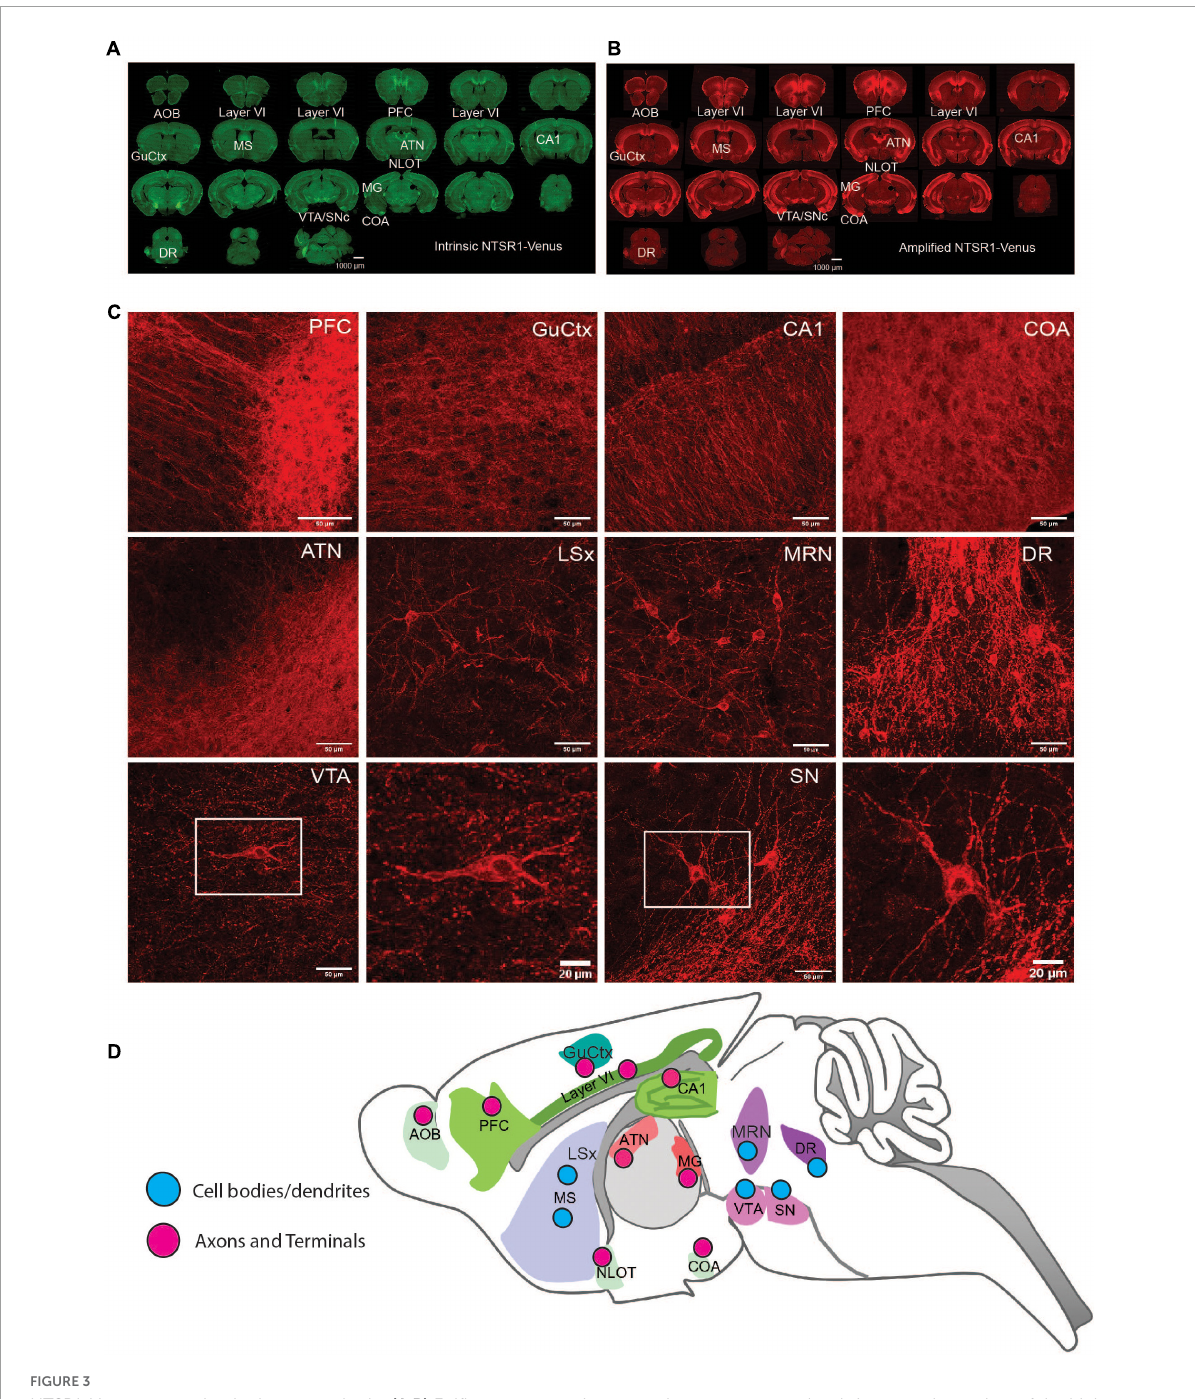
FIGURE3 NTSR1-Venus expression in the mouse brain. (A,B) Epifluorescence microscope images at macro-level. Annotated overview of the highest NTSR1-Venus expressing brain regions (see Table 2 ). Scale bars are 1000 µ m. (A) Green, intrinsic Venus. (B) Red, NTSR1-Venus is amplified with Anti-Venus antibody. Complete expression pattern is indicated in Table 2 and visualized in the 3D reconstruction of the amplified NTSR1-Venus (B) brain sections in Supplementary Video 3 ( n = 3 Ntsr1 Venus / Venus animals). (C) Confocal imaging of regions with distinct NTSR1-Venus subcellular expression. Scale bars are either 50 µ m for macro views or 20 µ m for magnified views of SN and VTA. (D) Scheme depicts map of subcellular expression pattern (cell bodies/dendrites or axons and terminals) for NTSR1-Venus in regions which highly express NTSR1-Venus. Brain region annotations: AOB, accessory olfactory bulb; ATN, anterior group of the dorsal thalamus; Amd, Anteromedial nucleus-dorsal; COA, Cortical amygdalar area; CA1, CA1 hippocampal region; CA2, CA2 hippocampal region; DG, dentate gyrus; DR, dorsal raphe nucleus; GuCtx, gustatory cortex; IFL, infralimbic area; LSx, lateral septal complex; MS, medial septum; MG, medial geniculate; MRN, midbrain reticular nucleus; NLOT, nucleus of the lateral olfactory tract; PFC, prefrontal cortex; SN, substantia nigra; VTA, ventral tegmental